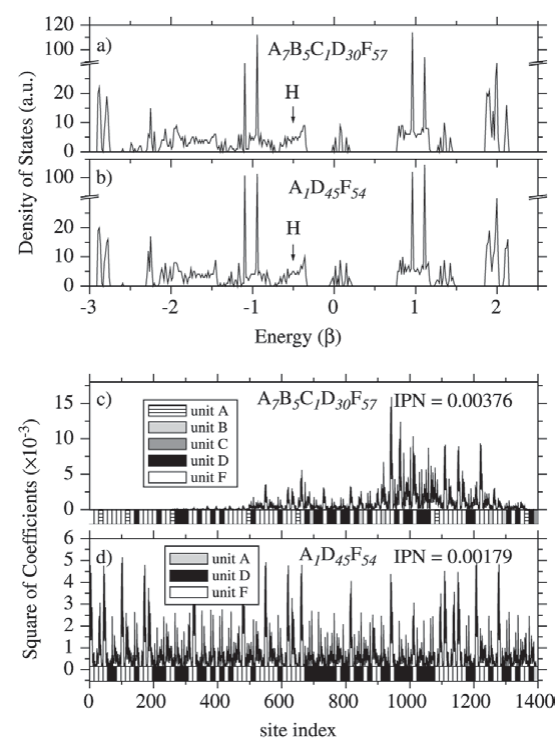
Figure 4. a) and b), Density of electronic states for the